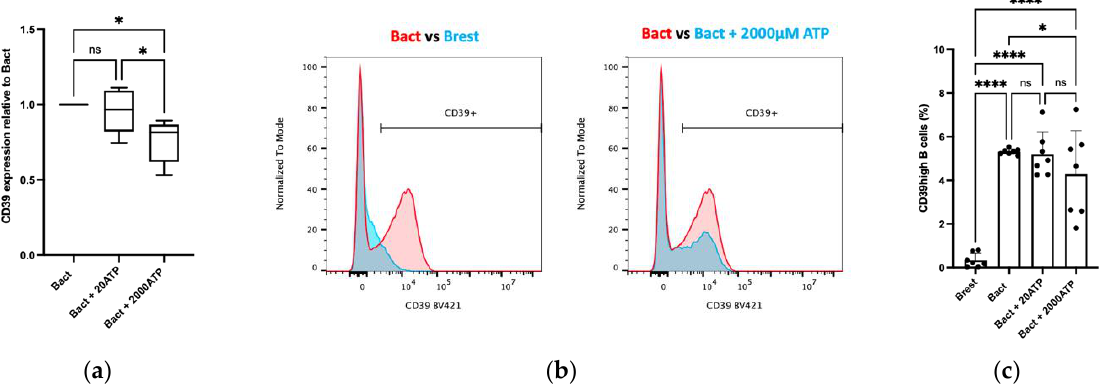
Figure 3. Flow cytometry data of CD39 expression on B cells in the presence of ATP (20 µM vs. 2000 µM). ( a ) Box plot graph illustrates the relative overall CD39 expression in activated B cells (Bact) and in the presence of ATP. The mean of six independent experiments with standard deviation is presented. The mean of each ATP intervention is related to Bact (value 1). The presence of 2000 µM ATP significantly decreased the CD39 expression in Bact. Bact vs. Bact + 2000 µM ATP: p * = 0.014; Bact + 20 µM ATP vs. Bact + 2000 µM ATP: p * = 0.012; ns = not significant: p > 0.05. ( b ) Activated B cells (Bact, red) showed a higher CD39 expression than resting B cells (Brest, blue). Bact with 2000 µM ATP (blue) showed a decreased CD39 expression. BV421 = Brilliant Violet 421. ( c ) Scatter dot bar charts of CD39high B cells (in %) after activation and in the presence of ATP. The mean of six independent experiments with standard deviation is presented. Activation of B cells increased the CD39high B-cell rate with high significance. Addition of 20 µM ATP did not impact the rate of CD39high B cells. The amount of 2000 µM ATP significantly decreased the rate of CD39high B cells. Brest vs. Bact: p **** < 0.0001; Brest vs. Bact + 20 µM ATP: p **** < 0.0001; Brest vs. Bact + 2000 µM ATP: p **** < 0.0001; Bact vs. Bact + 2000 µM ATP: p * = 0.047; ns = not significant: p > 0.05. Statistical significance was determined using a one-way ANOVA approach with multiple comparisons by controlling the false discovery rate.